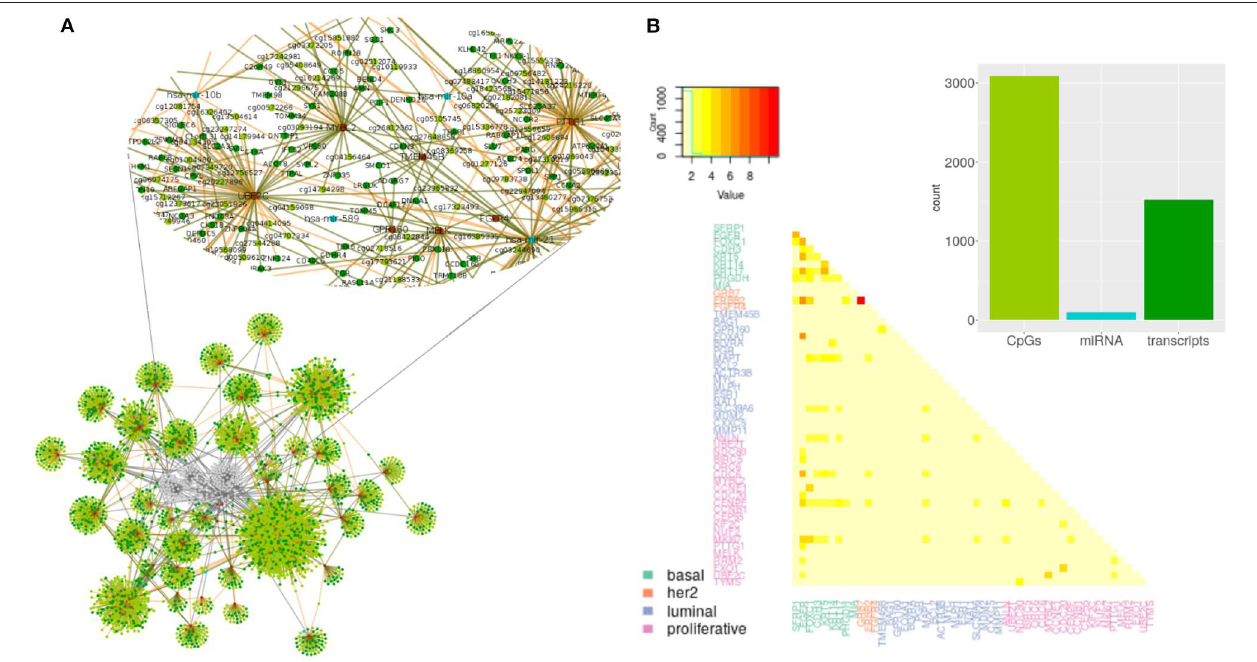
FIGURE 2 | Predictors selected per PAM50 gene for Basal subtype. (A) Topology of selected predictors and associated PAM50 genes. Brown circles are PAM50 genes. Transcripts are colored in dark green, miRNAs in blue, and CpGs in light green. Edges link each PAM50 gene with its selected predictors. The color of the line indicates the sign of the coefficient value associated with the predictor; negative values are in brown and positive ones in green. Zoom of the gray area shows the predictors selected for MYBL2 . (B) Summary of the network. Barplot with the total representation of each omic plus heatmap of the count of predictors shared by PAM50 genes.